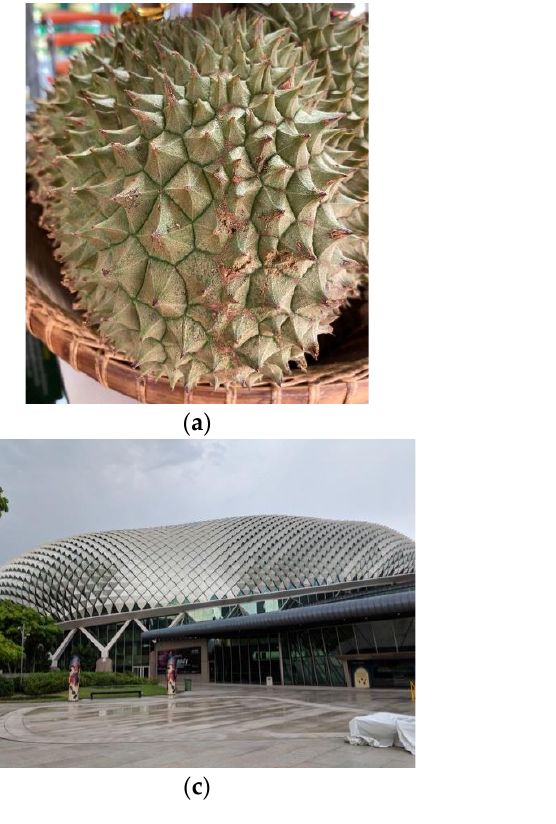
Figure 3. The Esplanade Theatres on the Bay, Singapore inspired by durian fruit shell characteristics ( Durio zibethinus ): ( a ) Durian fruit; ( b ) Esplanade theatre’s envelope detail; ( c ) Esplanade theatre building; ( d ) Esplanade theatre top view. Image ( a ): reprinted with permission 2021 © Natasha Heil. Image ( b – d ): reprinted with permission 2018 © Pierre Côté.